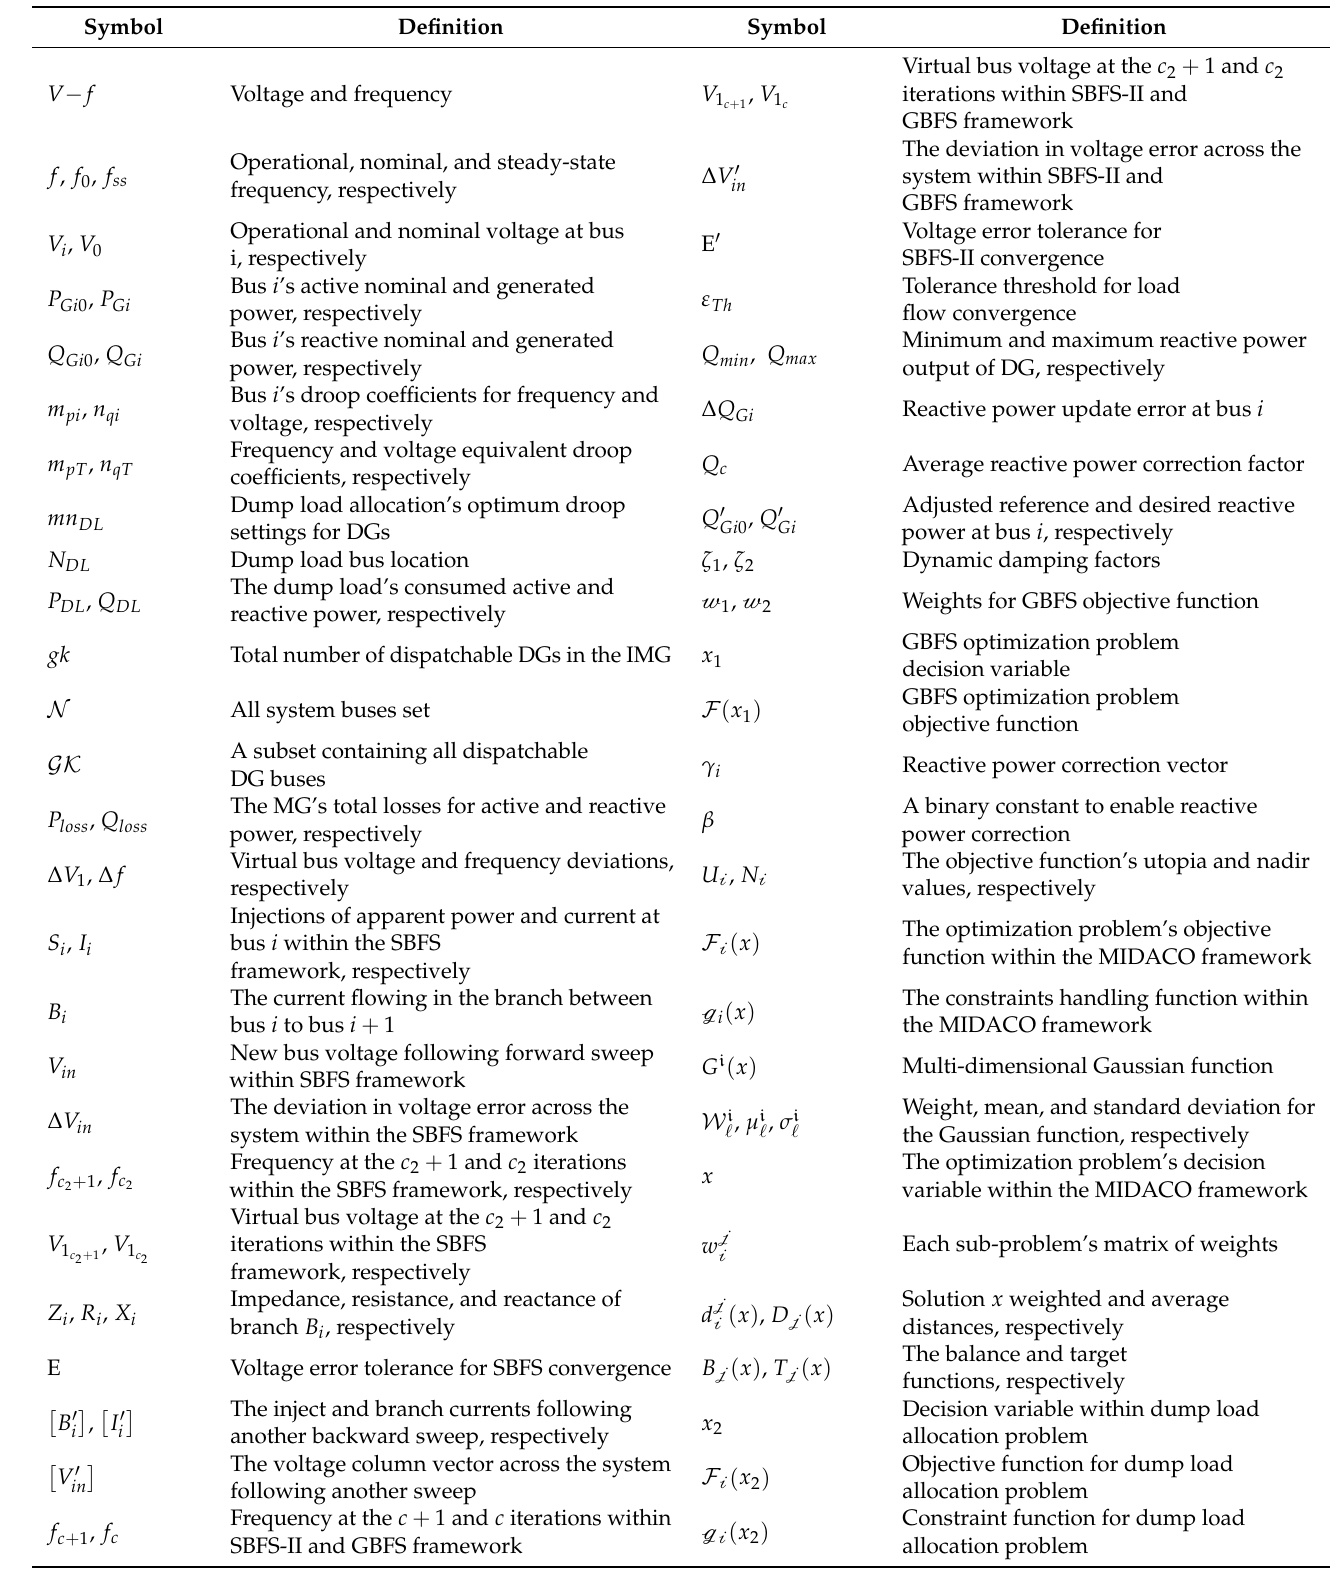
Table A1. List of symbols and